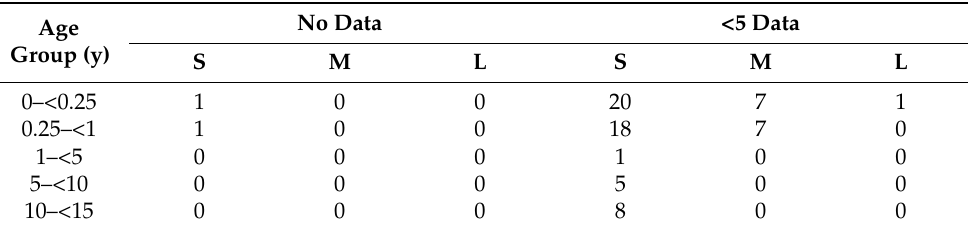
Table 5. Age groups with a small number of data.